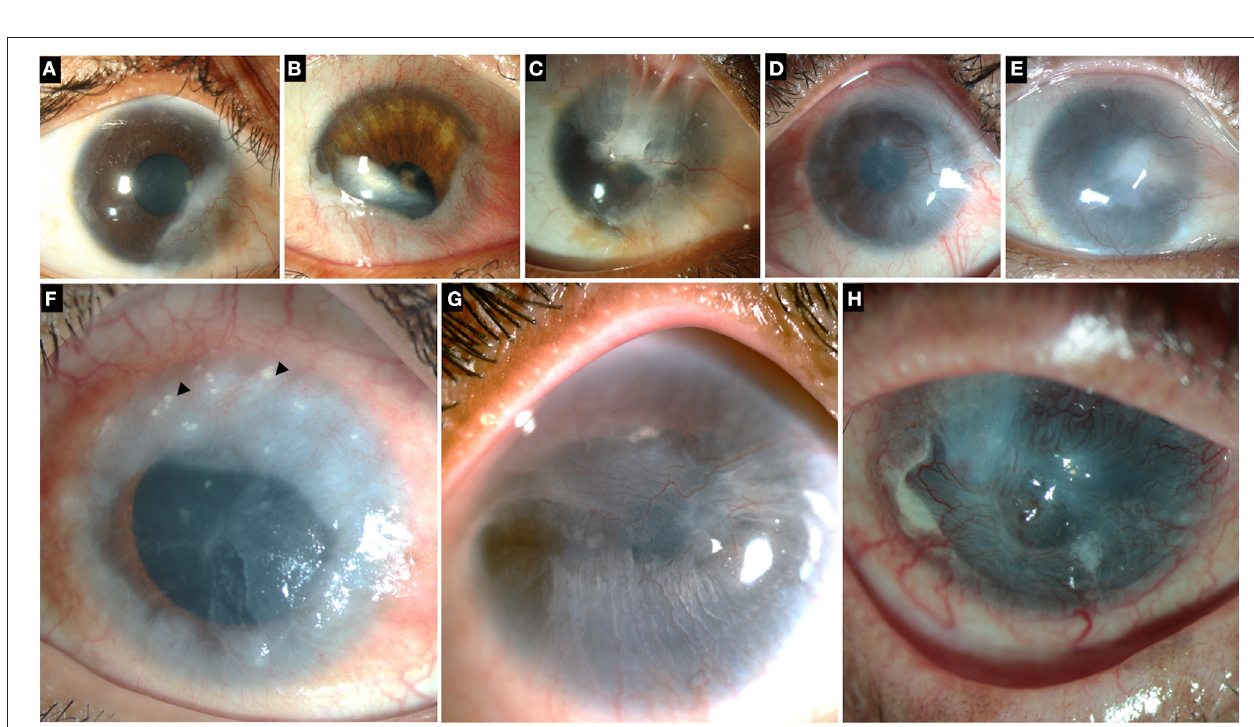
FIGURE 2 | Collage of images illustrating different grades and etiologies of limbal stem cell deficiency (LSCD). Top row: LSCD due to chemical injury which is partial and sparing the visual axis (A) , involving the visual axis (B,C) . (D,E) Total LSCD in chemical injury. (F) LSCD in chronic vernal keratoconjunctivitis. Superior cornea shows Horner-Trantas dots (black arrowheads). (G) LSCD in Epidermolysis Bullosa (H) LSCD in mucous membrane pemphigoid.